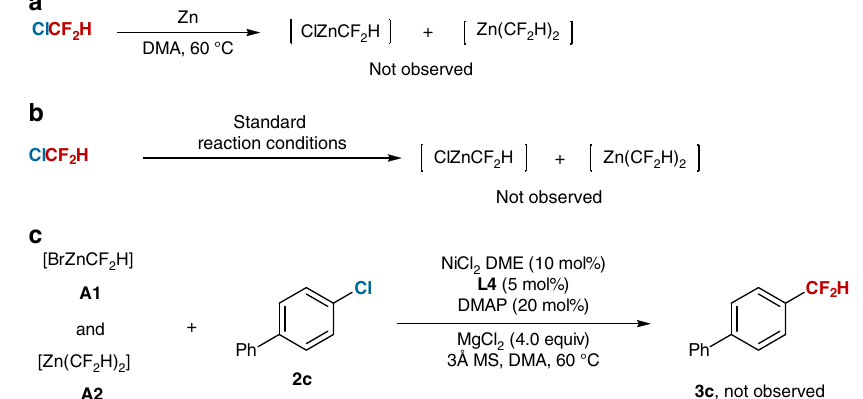
Fig. 3 Reaction of ClCF 2 H with zinc. a Reaction of ClCF 2 H with zinc in DMA. b Reaction of ClCF 2 H with zinc under standard reaction conditions. c Reaction of arylchloride 2c with di fl uoromethyl zinc